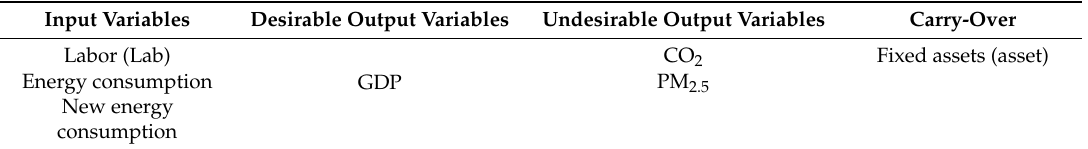
Table 1. Input and output